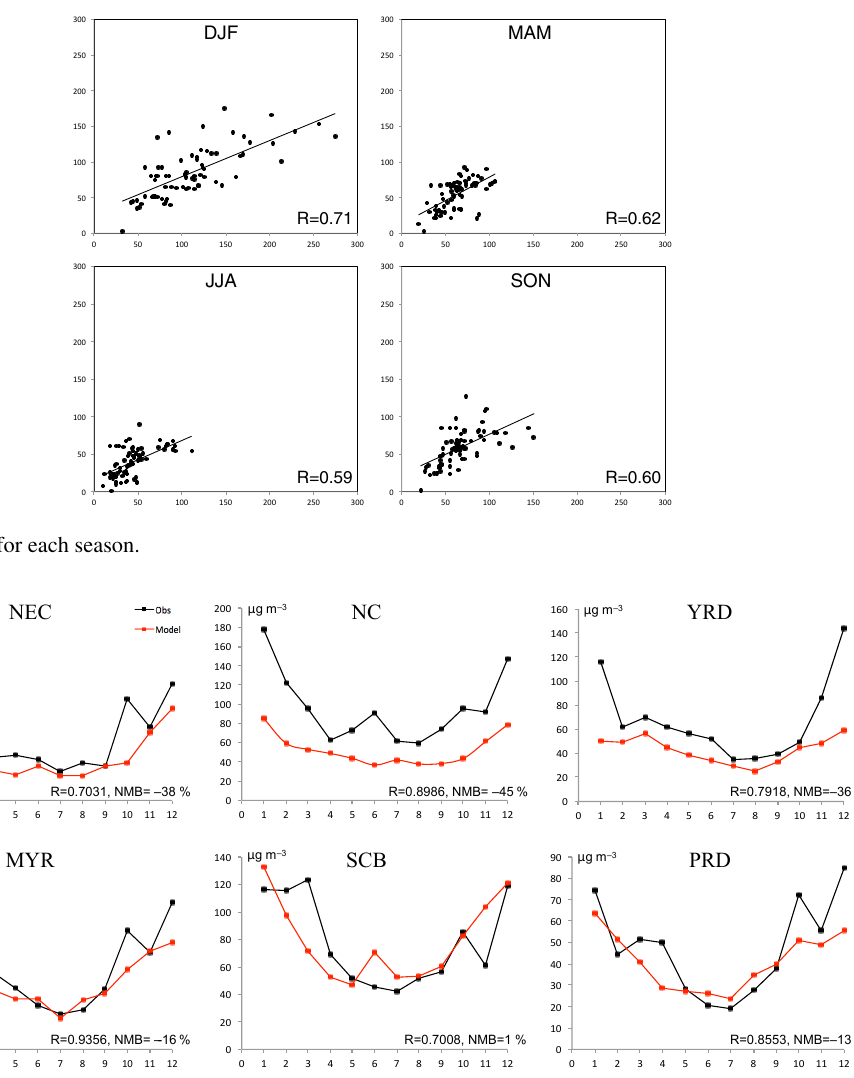
Figure 4. Monthly mean simulated and observed PM 2 . 5 in six key regions.